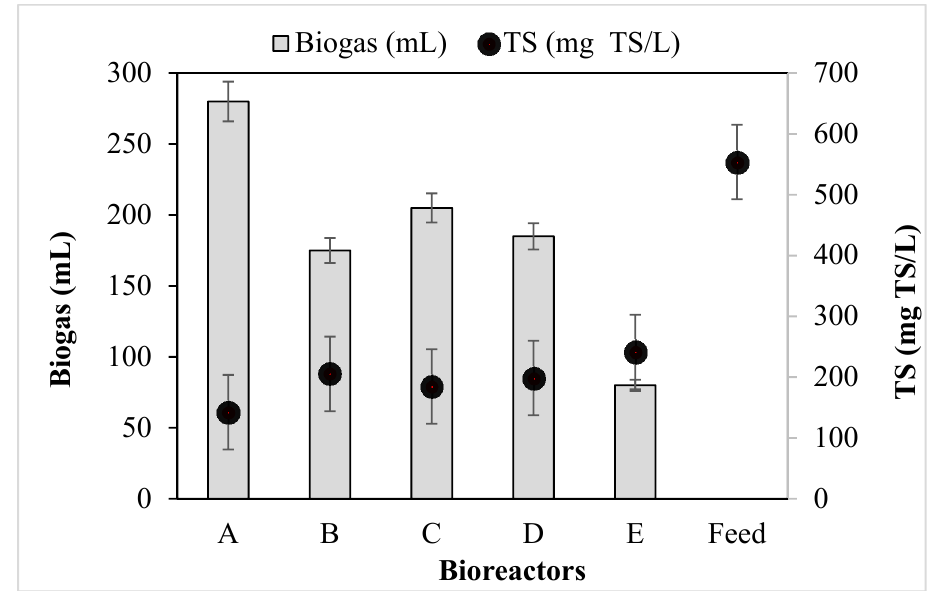
Figure 3. Biogas yield and TS degradation of bioreactors A–D charged with 2 g of ( A ) Fe 2 O 4 -TiO 2 ; ( B ) Cu-Fe 2 O 4 ; ( C ) Fe 3 O 4 ; and ( D ) Chitosan-Fe 2 O 4 /TiO 2 MNPs, whereas bioreactor E is a control: ( E ) no MNPs.